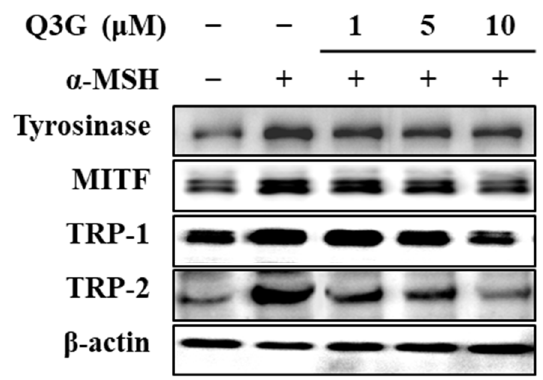
Figure 3. Effect of Q3G on expression of melanogenesis-related proteins, tyrosinase, MITF, TRP-1, and TRP-2 in α -MSH-stimulated B16F10 melanoma cells. Stimulated cells were treated with or without Q3G for 24 h, and the protein expression levels were quantified with western blot analysis. β -actin was used as internal loading control.